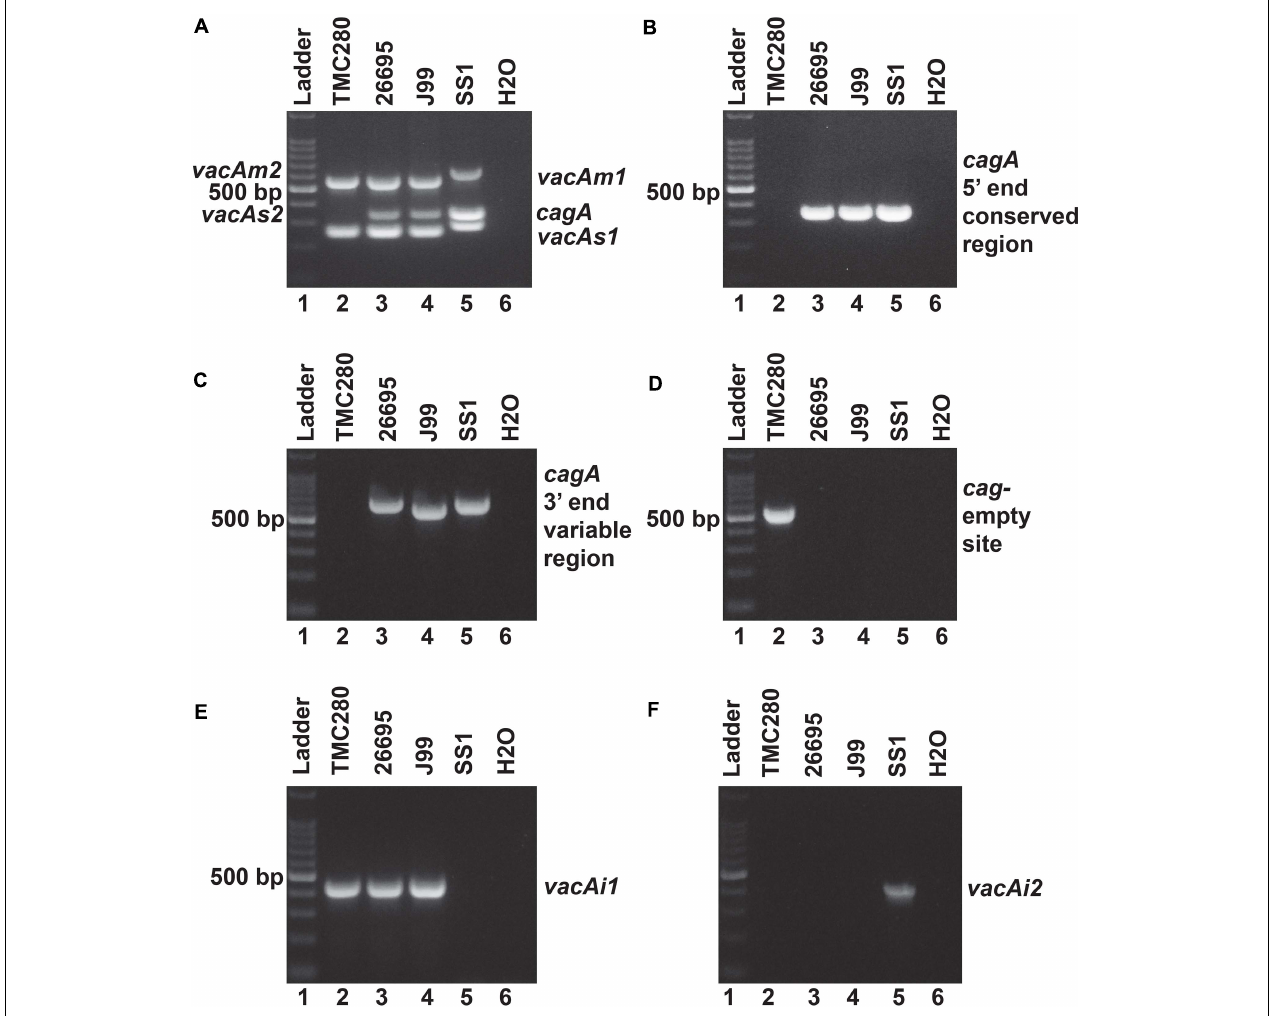
FIGURE 2 | (A) Multiplex PCR for the characterization of vacA alleles and cagA gene of strain TMC280. The strain TMC280 carry vacAs1m1cagA - genotype, while the strains used as positive controls like 26,695 ( vacAs1m1cagA +), J99 ( vacAs1m1cagA +), and SS1 ( vacAs2m2cagA –) gave amplicons at expected sizes. (B) No cagA specific amplicon were obtained for the strain TMC280 when the primers are targeted at the 5 (cid:48) end conserved regions of the cagA gene. The positive controls, 26,695, J99, and SS, as expected, gave specific amplicons. (C) The PCR targeting the 3 (cid:48) end variable region of the cagA gene. The strain TMC280 did not give any amplification with these primers, while the positive controls, 26,695, J99, and SS1, did. (D) The cag -empty site PCR. Only the strain TMC280, but not the strains 26,695, J99, and SS, gave amplicon for this PCR. (E) The PCR for the vacAi1 allele. The strain TMC280, along with 26,695 and J99, gave amplicon for the vacAi1 allele. The strain SS1, as expected did not give the vacAi1 specific amplicon. (F) The PCR for the vacAi2 allele. The strain TMC280 as well as the strains 26,695 and J99 were negative for this PCR, but the strain SS1 was positive. Therefore, it is confirmed that the strain TMC280 has vacAs1i1m1cagA-